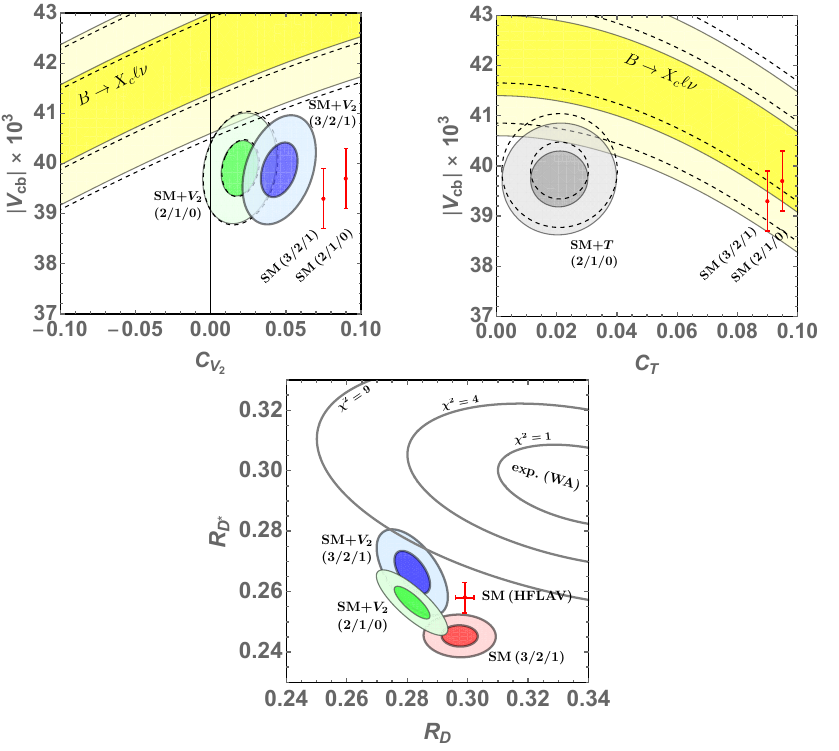
in the SM + NP scenarios. The regions in blue, V cb j j . The dashed lines are the V cb j j = 0 : 05 and C = 0 : 02 in the T V 2 and R in the D D (cid:3)